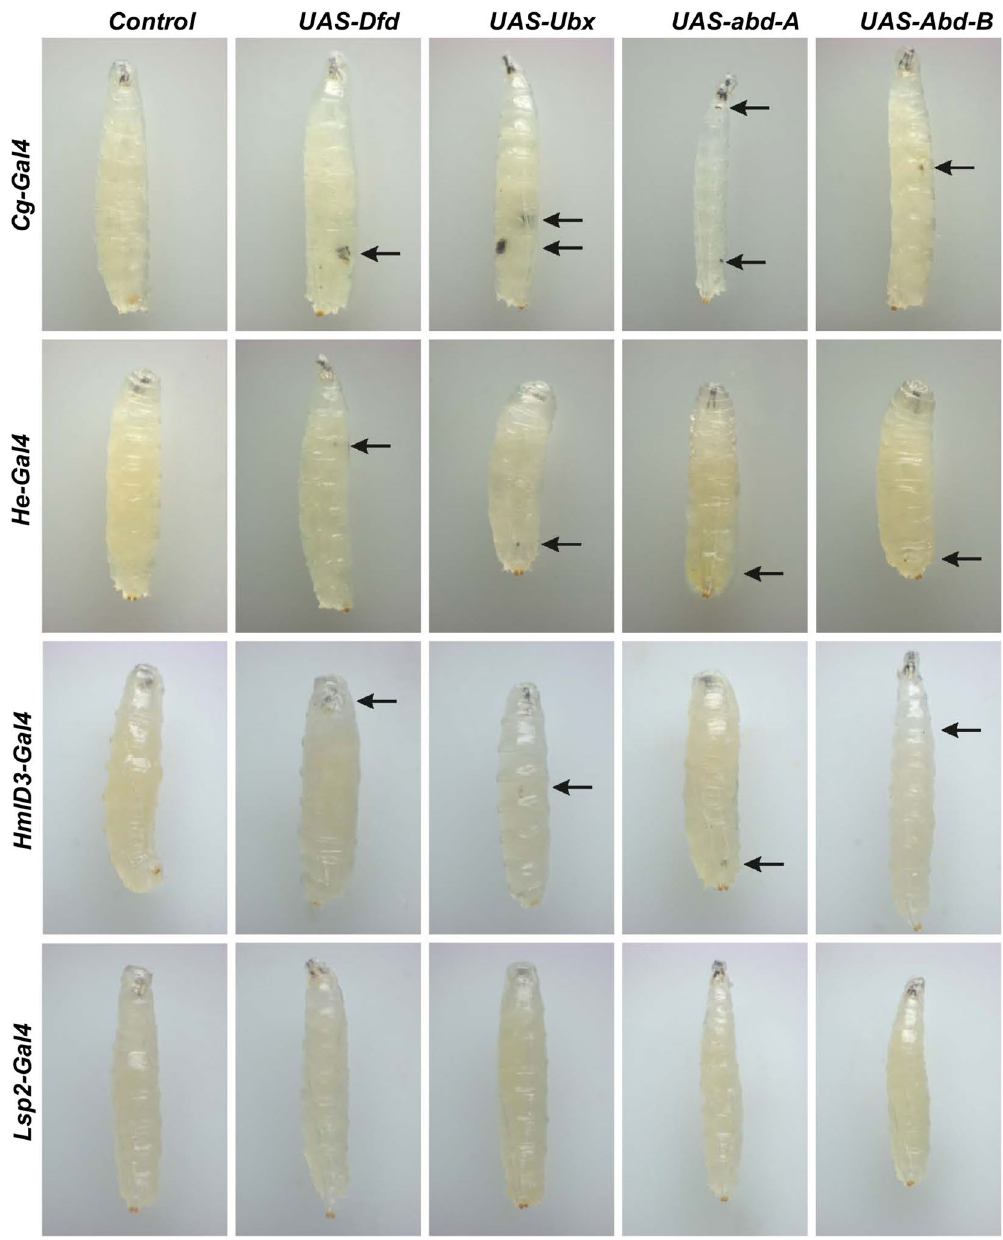
Figure 1. Larvae with subcutaneous tumors. Dfd, Ubx, abd-A and Abd-B , when expressed under the drivers Cg, He and HmlD3 lead to melanized bodies in the